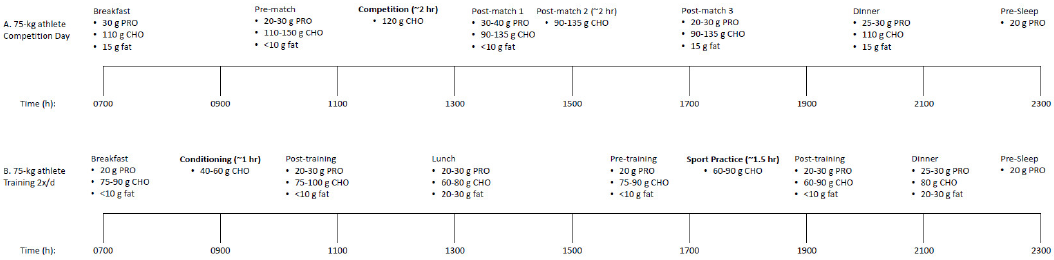
Figure 1. Sample nutrient timing strategy for a 75-kg power-endurance athlete (i.e., soccer) for (A) competition day and (B) conditioning session + team practice.